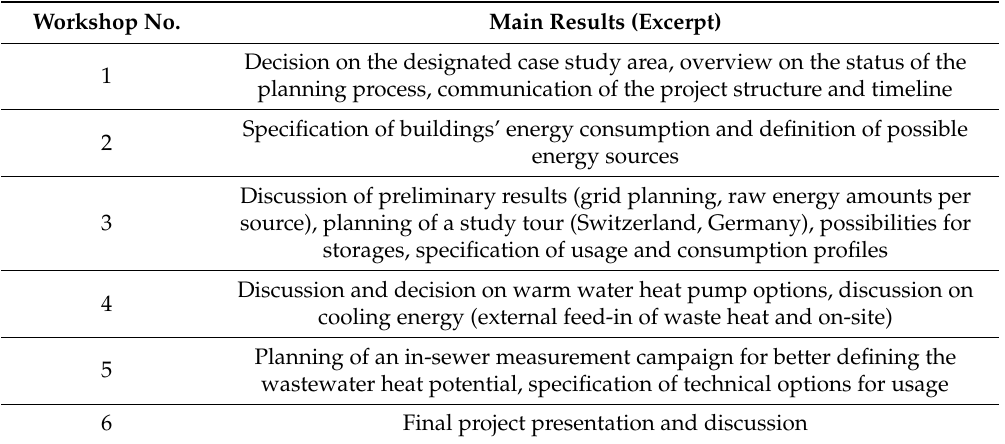
Table 2. Workshop structure with the Advisory board throughout the project. Workshop